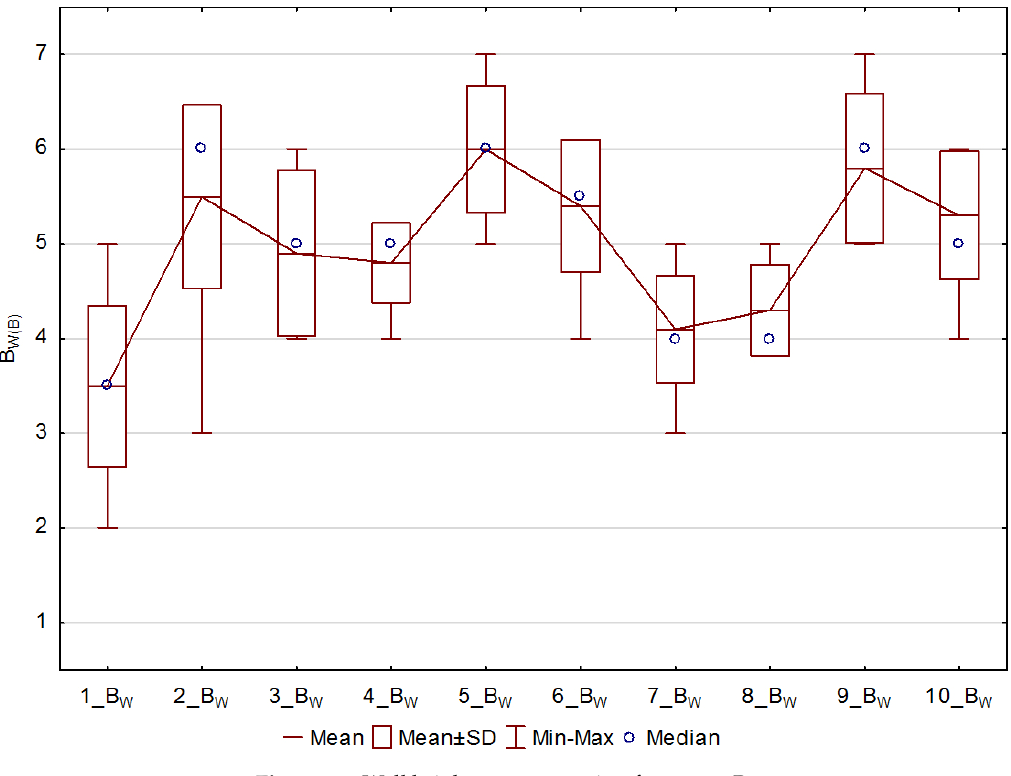
Figure 19. Wall brightness perception for group B.